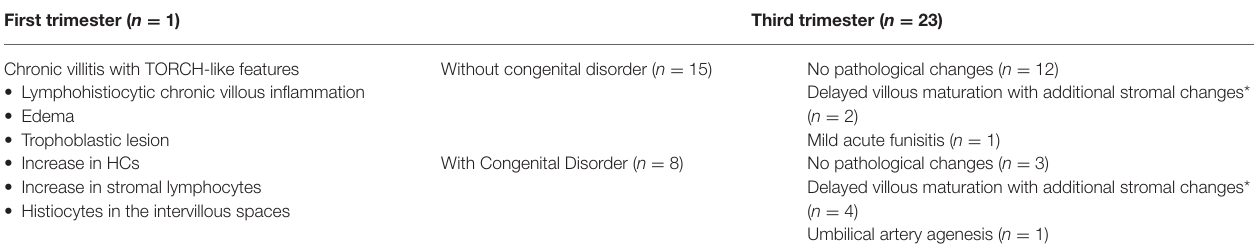
TABLE 2 | Main placental histopathological findings from infants with and without congenital disorder at